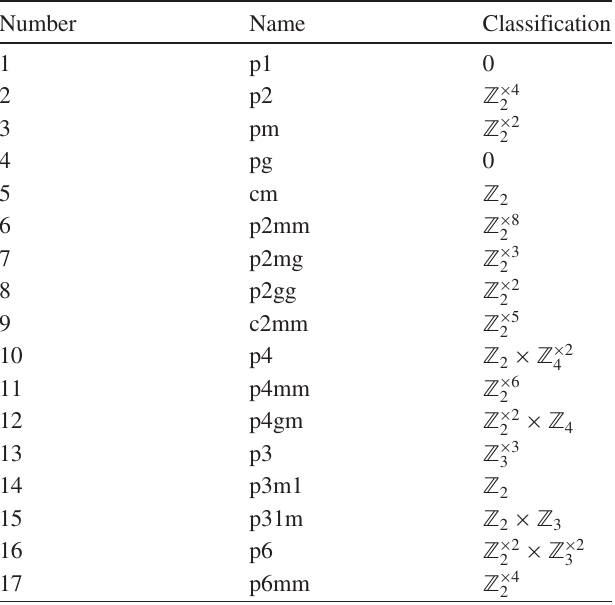
TABLE I. The classification of bosonic SPT phases in ( 2 þ 1 )- D protected by space-group symmetries, for each of the 17 2D space groups (sometimes known as “ wallpaper groups ”